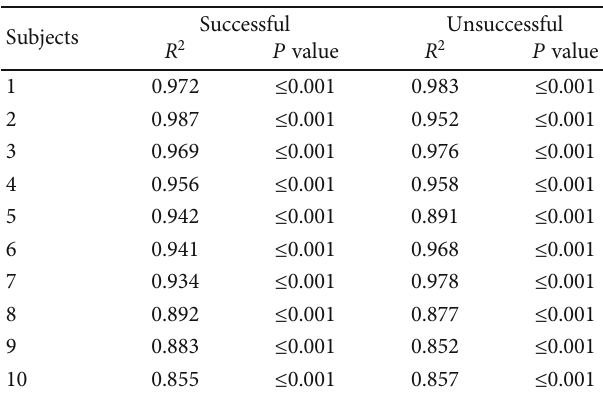
Table 8: R 2 value of linear regression equation of variation trend of the human and bar combination barycenter on the X